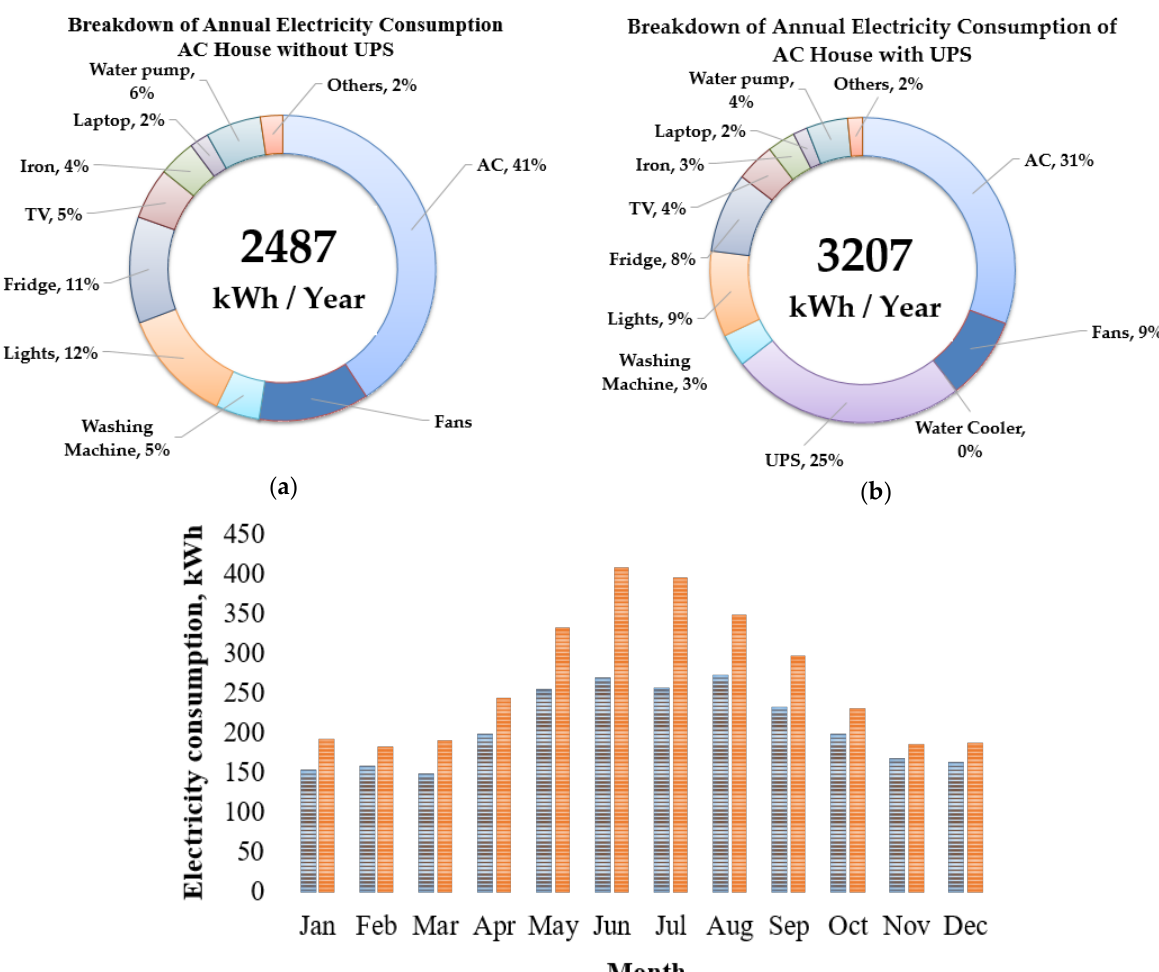
Figure 8. ( a ) Breakdown of Annual Electricity Consumption of a Non-AC House without UPS, ( b ) Breakdown of Annual Electricity Consumption of a Non-AC House with UPS ( c ) Monthly electricity consumption of non-AC houses with and without UPS.